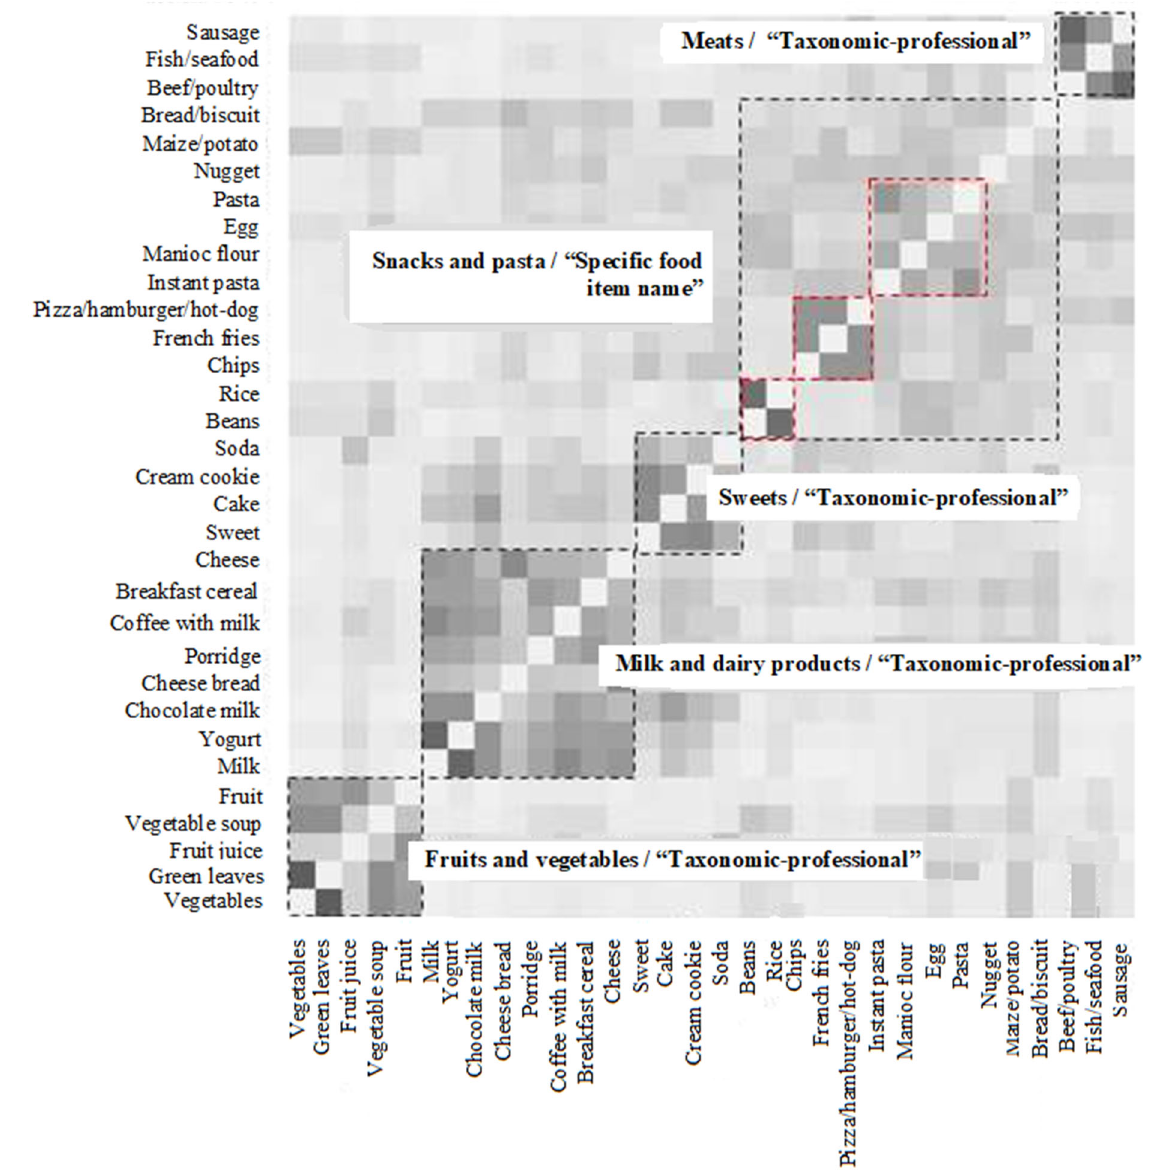
Figure 1. Clusters derived by cluster analysis.